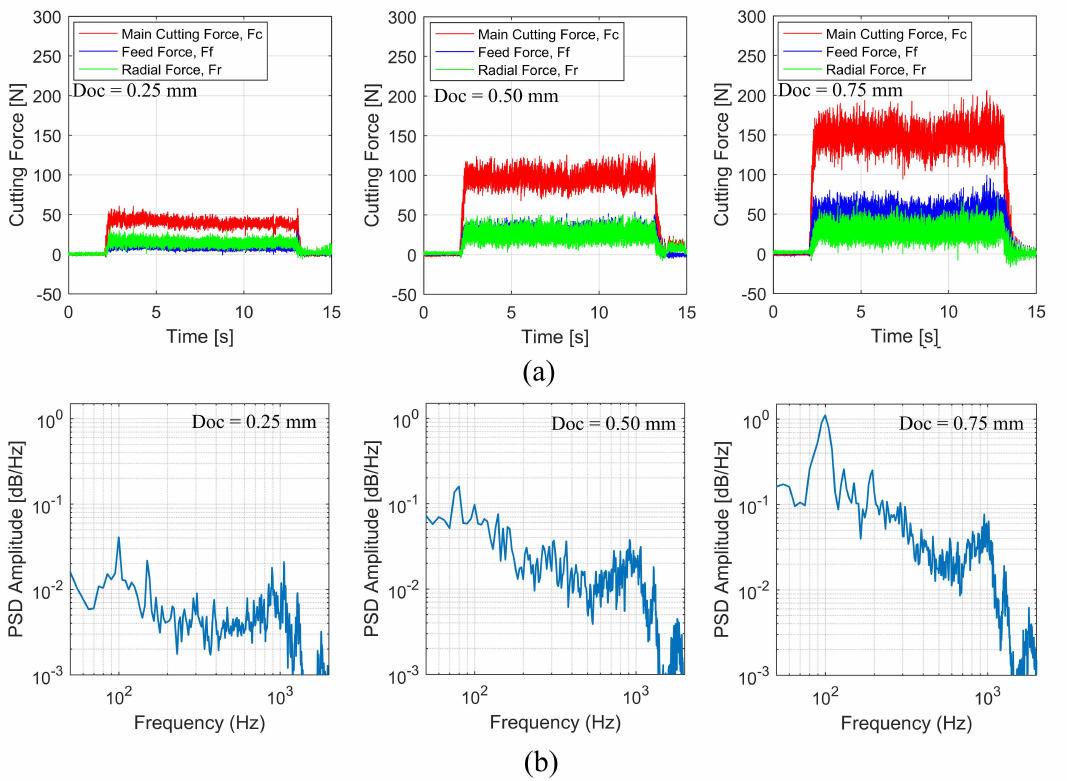
Figure 12. Cutting forces in turning operation under three different depths of cut: ( a ) time domain; ( b ) frequency